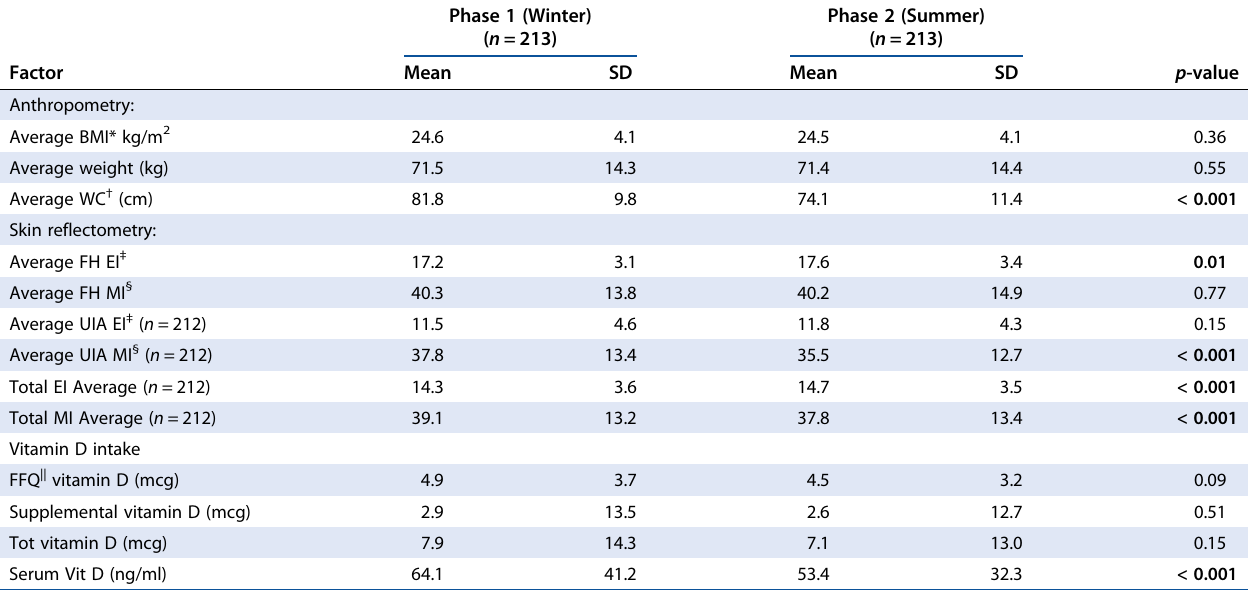
Table 3: VEPAC paired analysis of participants who returned for phase 2 of study